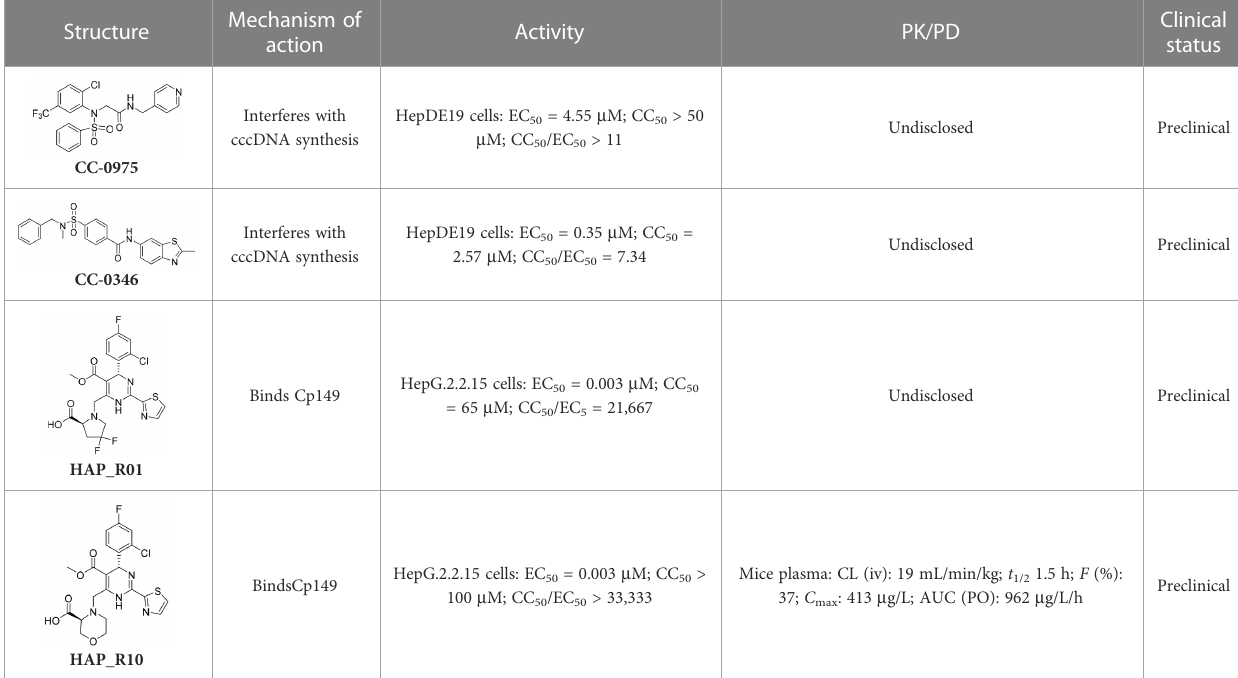
TABLE 2 A summary of compounds that interfere with the function of cccDNA minichromosomes.